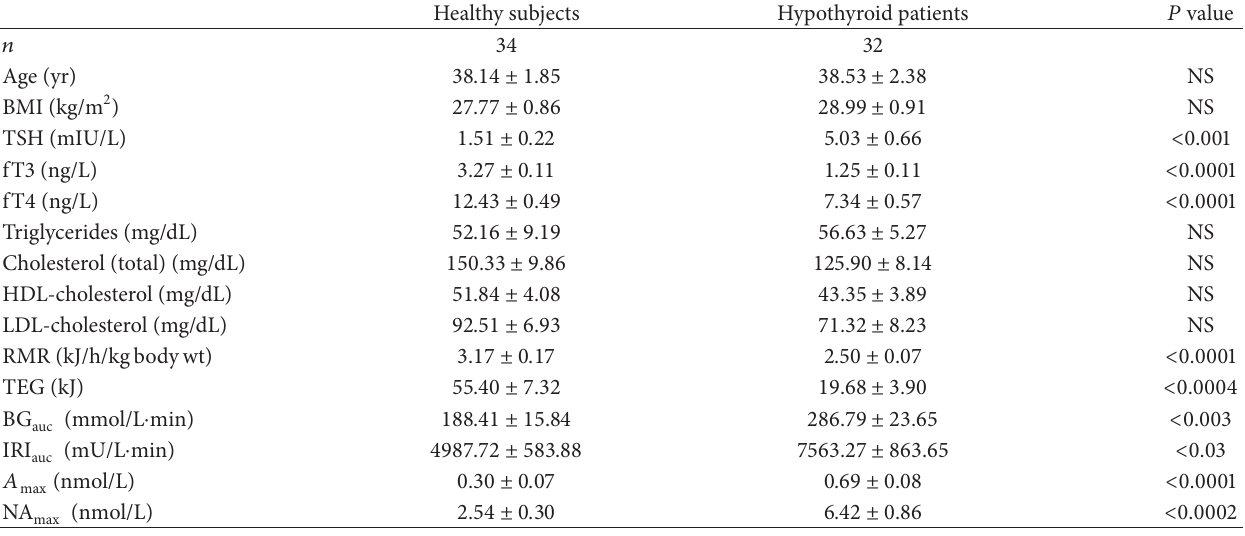
Table 1: Comparison of healthy and hypothyroid females: subjects’ characteristics and results of OGTT test.